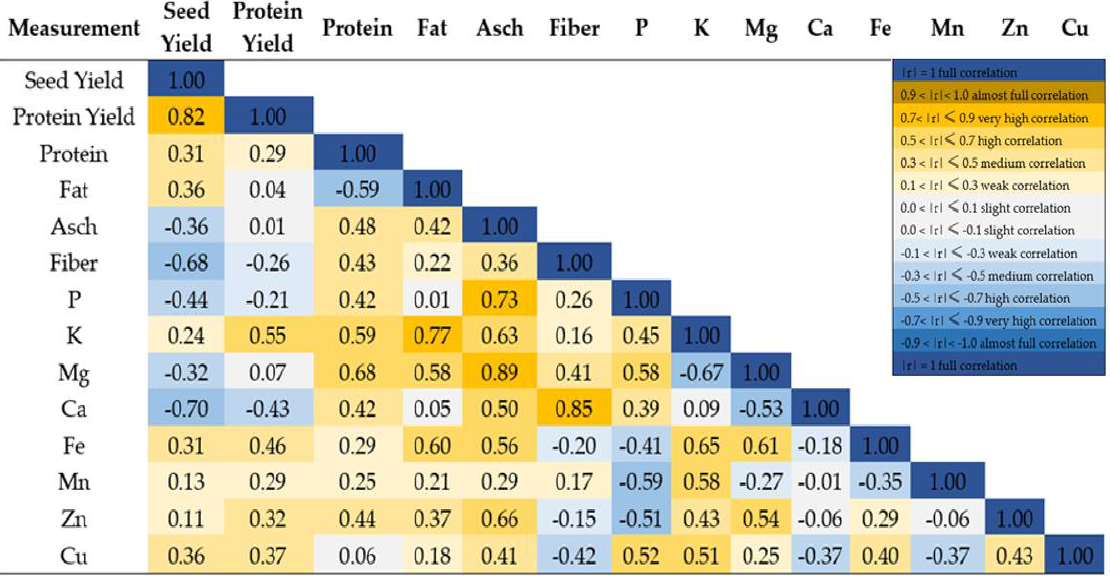
Figure 5. Correlation coefficients (r) between the parameters of the chemical composition of seeds.